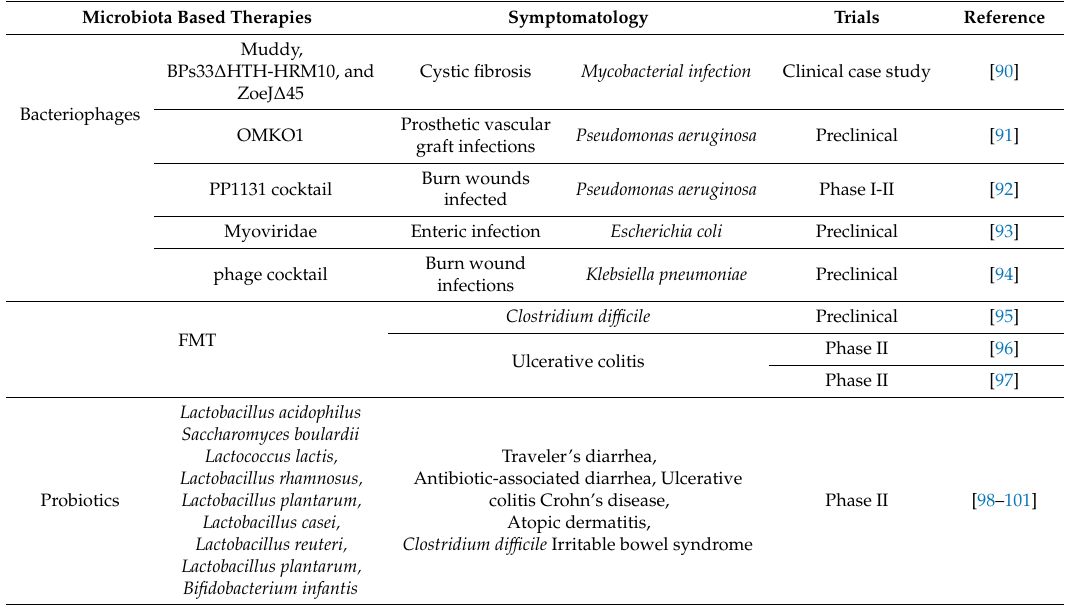
Table 2. Examples of microbiota-based therapeutic strategies and development phase (not intended to be